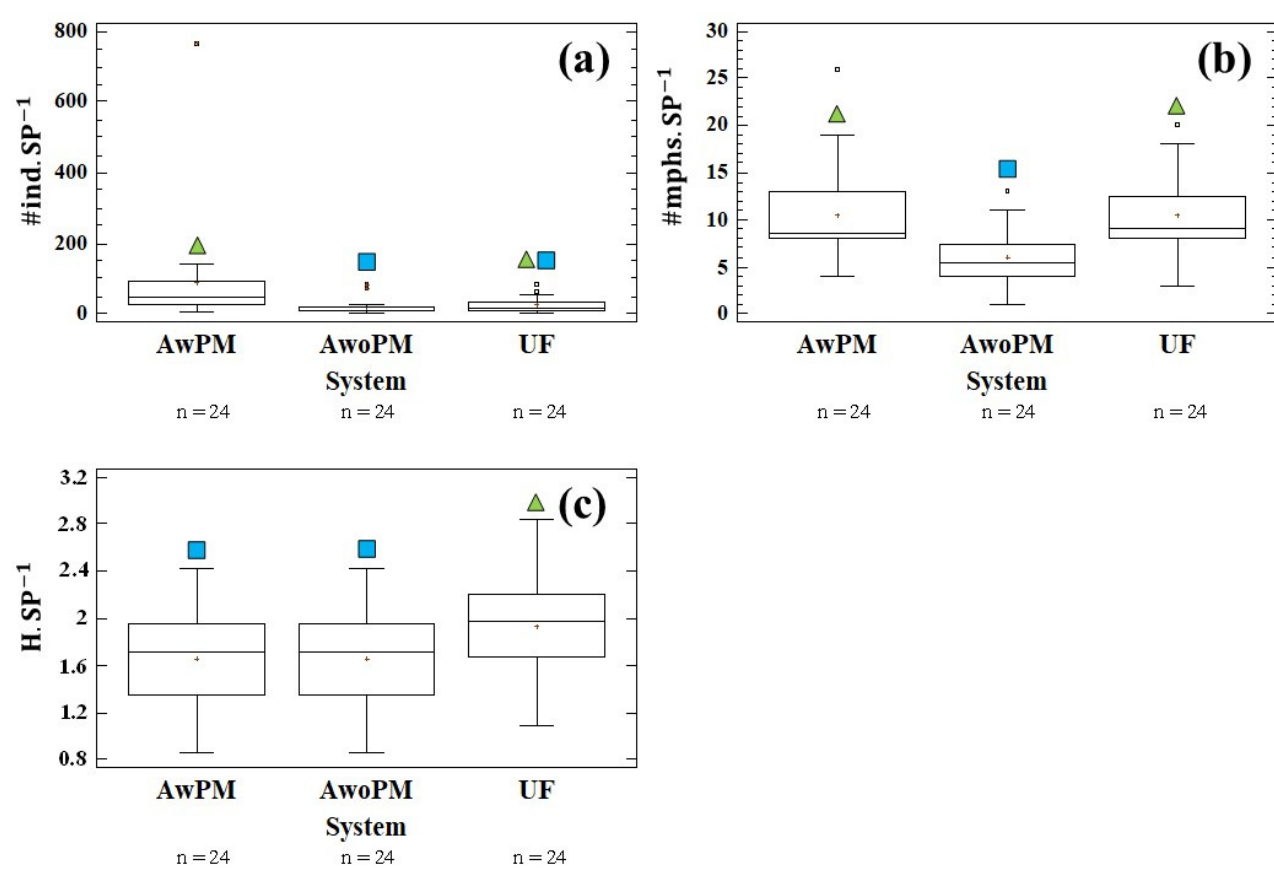
Figure 6. ( a ) Number of individuals per sampling point (#inds SP − 1 ), ( b ) the number of morphospecies per sampling point (#mphs SP − 1 ) and ( c ) Shannon diversity index per sampling point (H SP − 1 ) in each system. Each small square indicates an outlier, + = mean, middle horizontal line indicates median, n = number of sampling points for statistical analysis. Different geometric figures implies significantly different groups (Mann–Whitney U test, p < 0.05). AwPM = agriculture with plastic mulch and GLY; AwoPM = agriculture without plastic mulch and use of GLY; UF = unmanaged farming system.